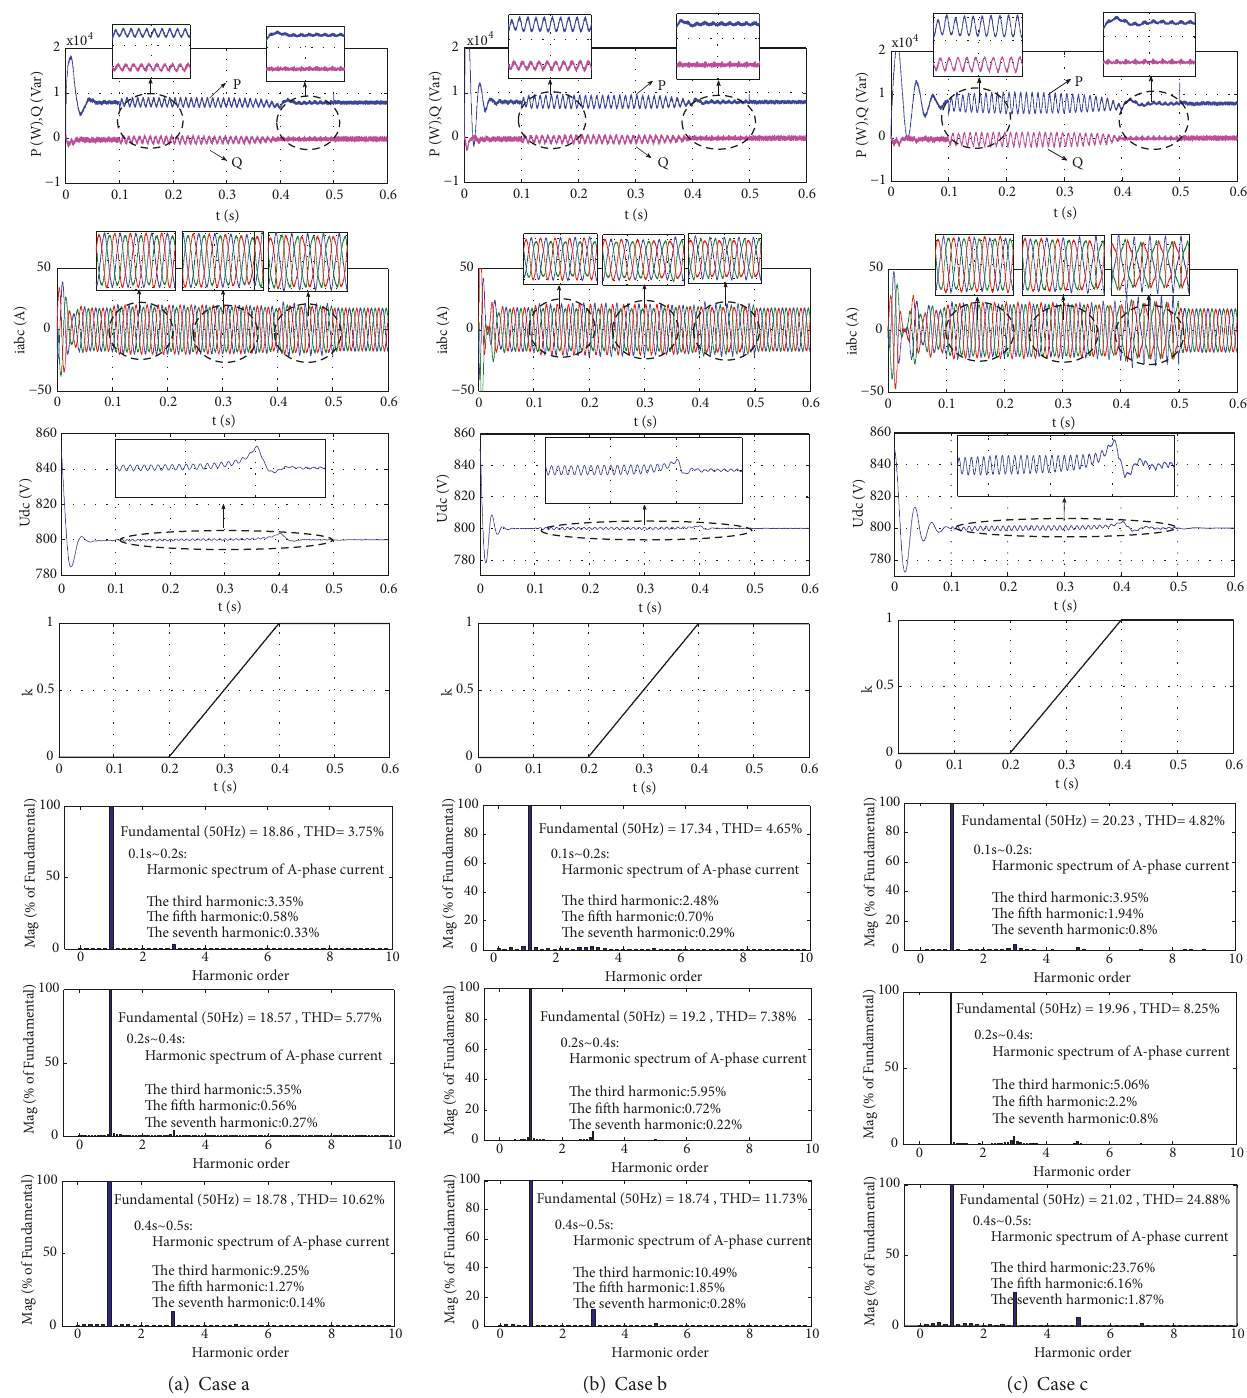
0.1s~0.2s: Harmonic spectrum of A-phase current The third harmonic:3.95% The fifth harmonic:1.94% The seventh harmonic:0.8% 8 100 Harmonic Fundamental (50Hz) = 19.96 , THD= 8.25% 0.2s~0.4s: Harmonic spectrum of A-phase current The third harmonic:5.06% The fifth harmonic:2.2% The seventh harmonic:0.8% 8 100 Harmonic Fundamental (50Hz) = 21.02 , THD= 24.88% 0.4s~0.5s: Harmonic spectrum of A-phase current The third harmonic:23.76% The fifth harmonic:6.16% The seventh 8 100 Harmonic